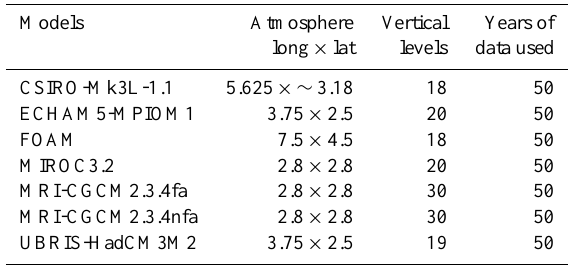
Table 1. PMIP2 models used in this study. Models